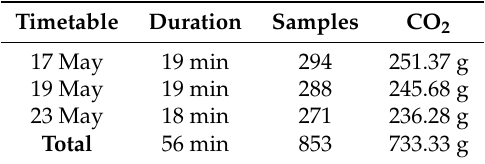
Table 7. Summary of data collected from a Toyota Etios